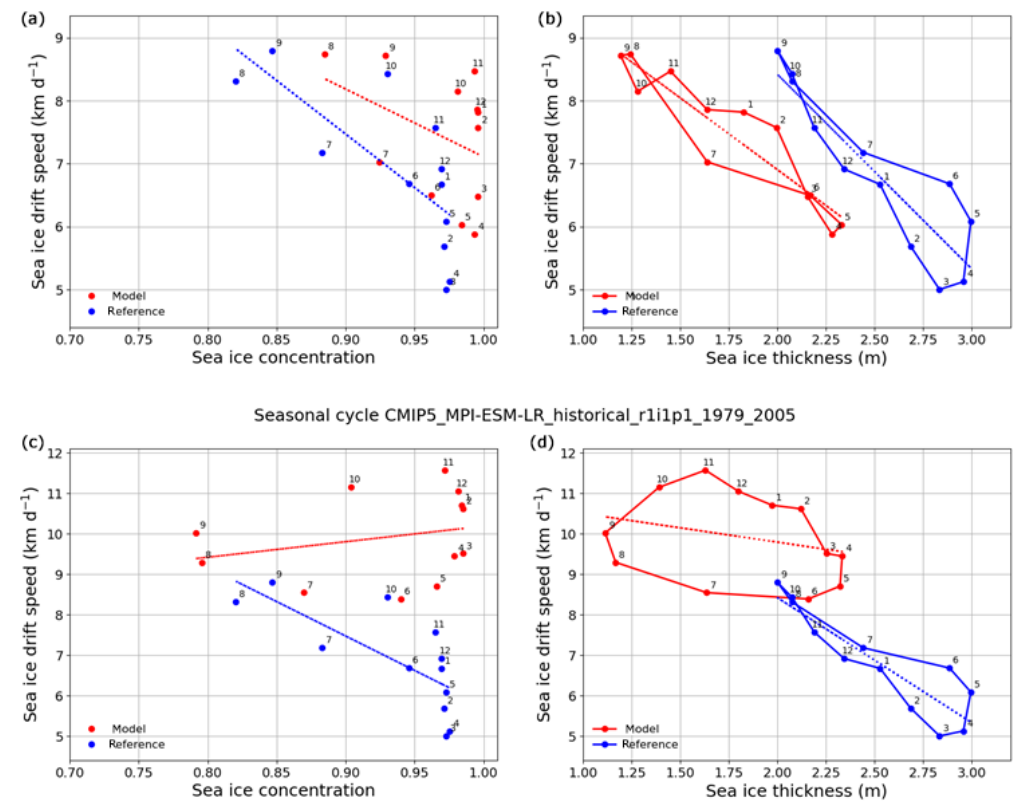
Figure 32. Scatter plots of modelled (red) and observed (blue) monthly mean sea ice drift speed against sea ice concentration (a, c) and sea ice thickness (b, d) temporally averaged over the period 1979–2005 and spatially averaged over the SCICEX box. Panels (a, b) show results from the GDFL-ESM2G model and (c, d) show results from the MPI-ESM-LR model (CMIP5 historical runs). Observations/reanalysis are shown in all panels (IABP for drift speed, OSI-450 for concentration, and PIOMAS for thickness). Numbers denote months. Dotted lines show linear regressions. This figure was produced in a similar way to Fig. 4 of Docquier et al. (2017) with recipe_sea_ice_drift.yml ; see details in Sect.